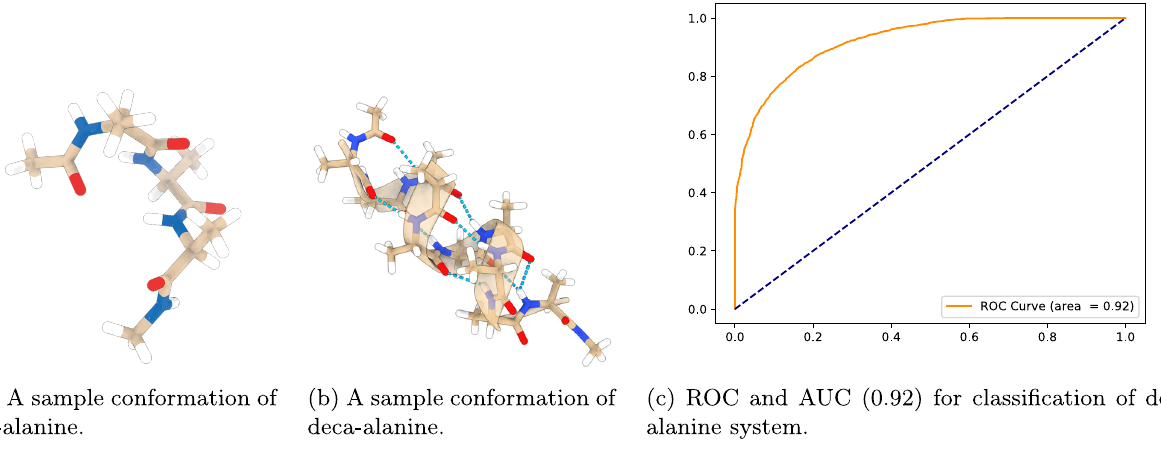
Fig. 6 Molecules used in training and testing of the model along with its ROC and AUC. Tri-alanine ( A ) was used in training the system, deca-alanine ( B ) was used in testing the system, and the resulting ROC and AUC ( C ).